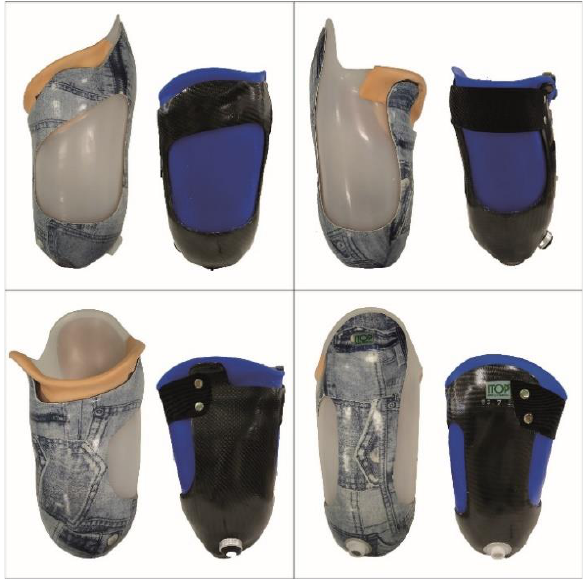
Figure 1: Differences between Ischial Containment Socket (left side - grey socket) and Hybrid Subischial Socket (right side - blue socket). Top left: frontal view. Top right: posterior view. Bottom left: medial view: Bottom right: lateral view.